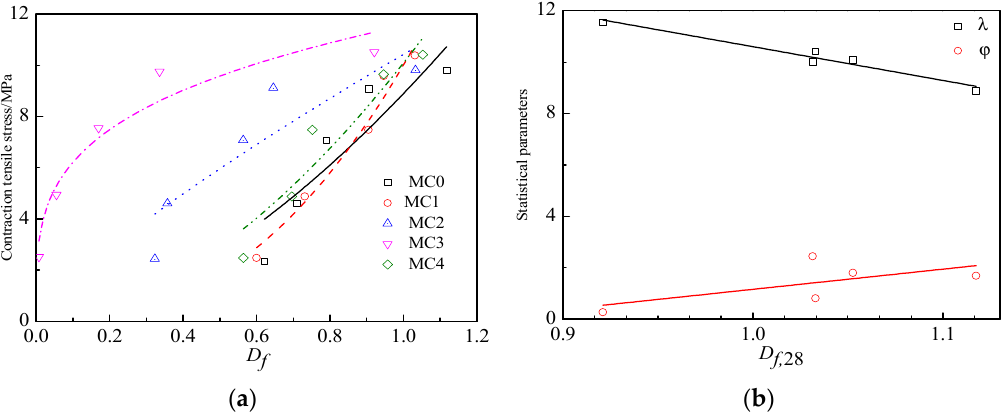
Figure 11. The relationship between contraction tensile stress and statistical parameters and D f : ( a ) σ ( t ) with D f ; ( b ) statistical parameters with D f ,28 . The relationship between shrinkage tensile stress σ ( t ) and fractal dimension D f of NCM plate can be expressed